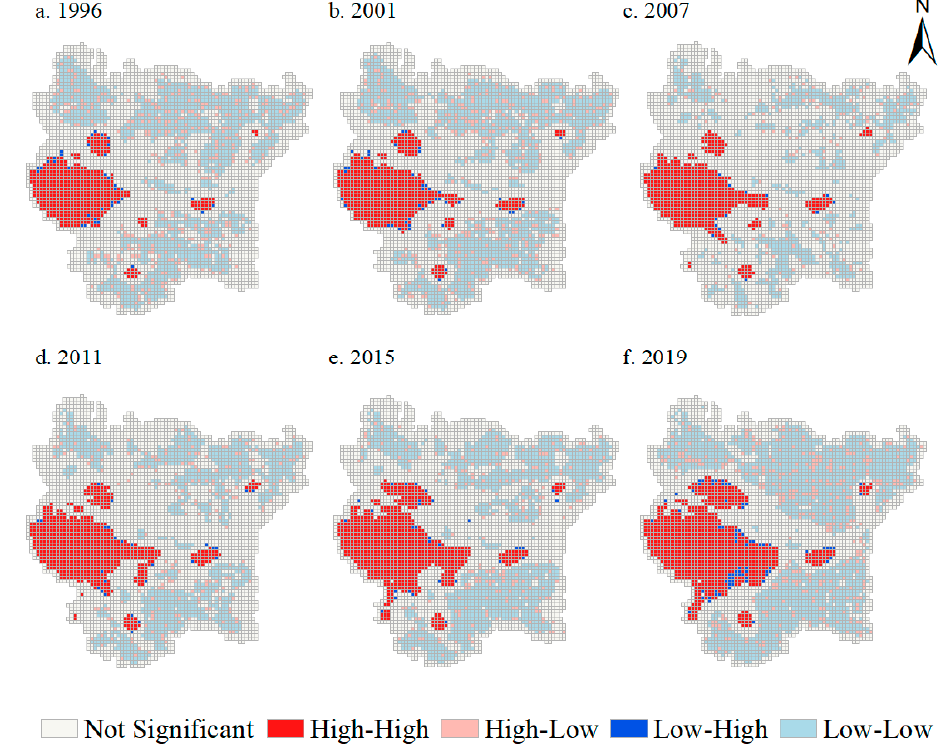
Figure 13. LISA cluster map of impacts of the percentage of built-up land (PLAND) on land surface temperature (LST) from 1996 to 2011.